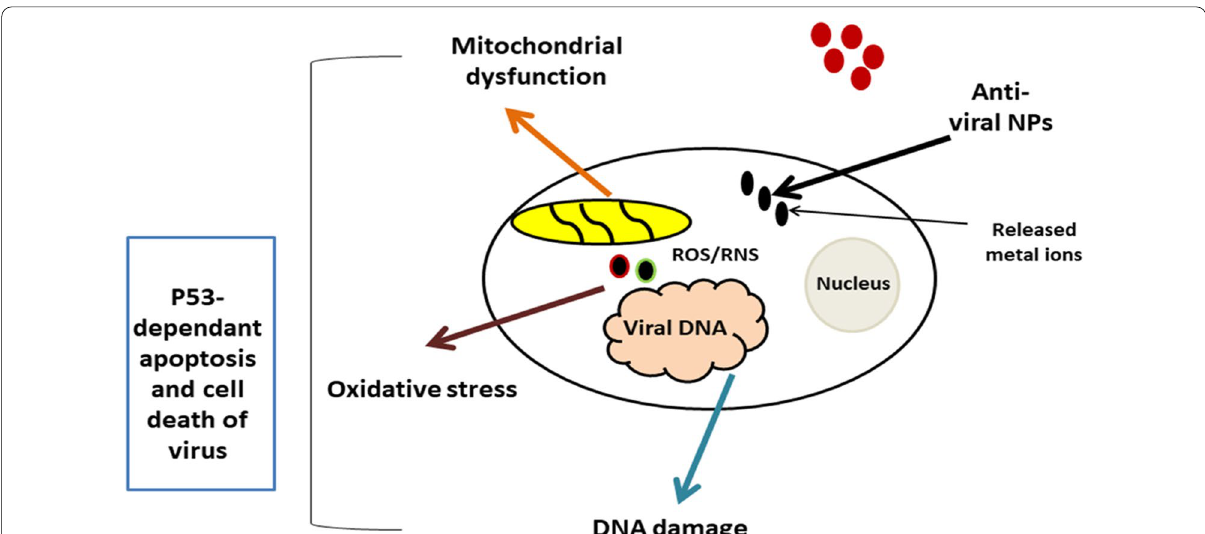
Fig. 4 Schematic illustration demonstrates the anti-viral action of metallic NPs. The anti-viral activity of metallic NPS is largely due to the induction of oxidative stress and generation of reactive oxygen species (ROS), which finally leads to mitochondrial dysfunction, which in turn results in DNA damage via a ROS-mediated mitochondrial intrinsic p53-dependent apoptotic pathway or via the autophagy-signaling